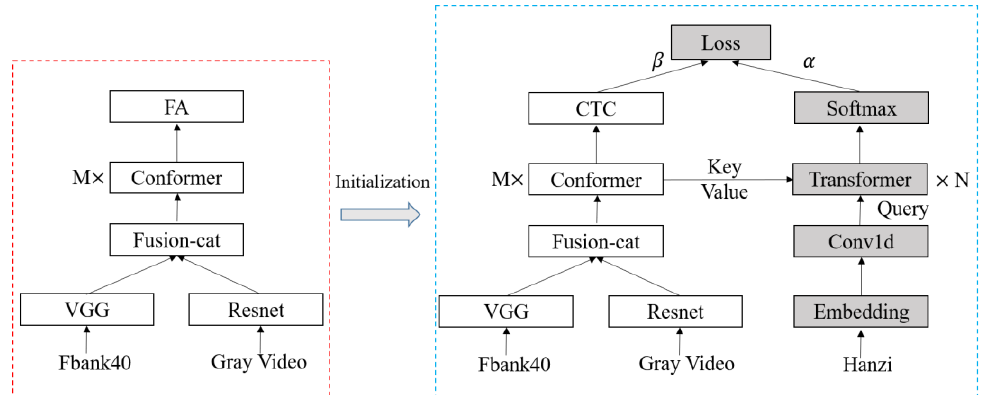
Figure 2. Pre-training with the hybrid system.